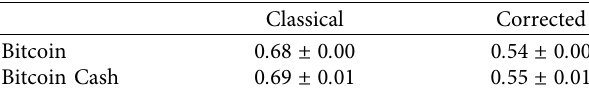
Table 3: Hurst exponent.